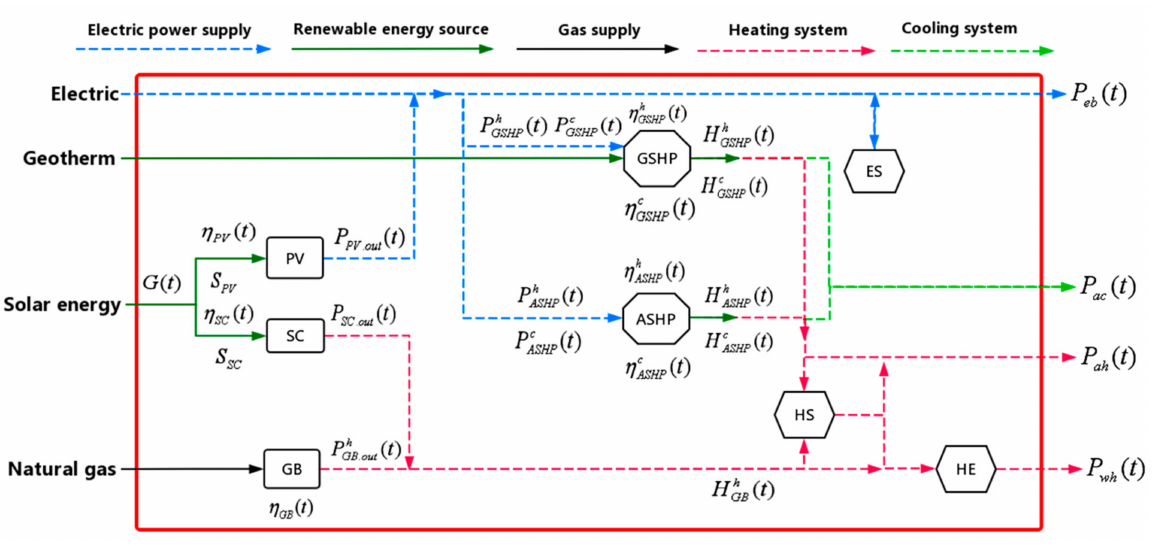
Figure 1. MCDES energy